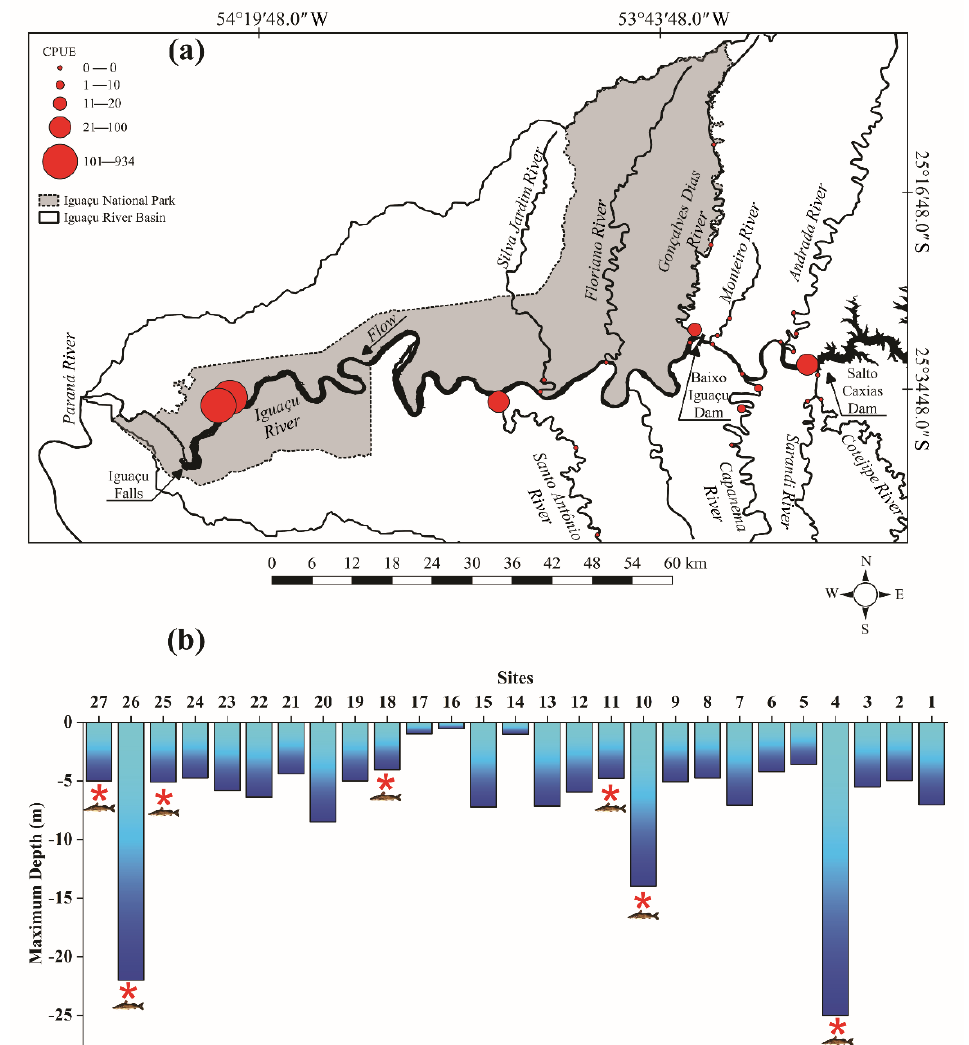
Figure 3. Spatial distribution of Steindachneridion melanodermatum with respective abundances (CPUE in the red bubble) ( a ) and maximum depths ( b ) of sampling sites that were examined in Lower Iguaçu, from downstream of the Salto Caxias Dam to upstream of Iguaçu Falls. Asterisks (*) indicate sites where the species were found.